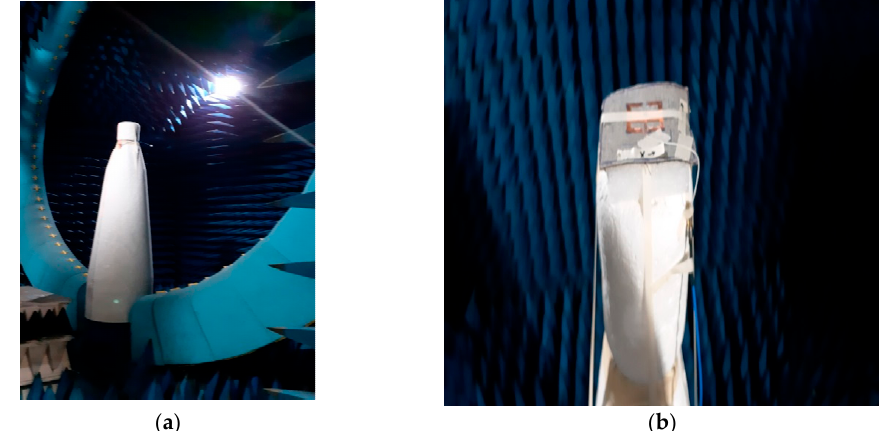
Figure 6. Photos of the antenna prototype in an anechoic chamber room: ( a ) The chamber room; ( b ) Antenna being tested.